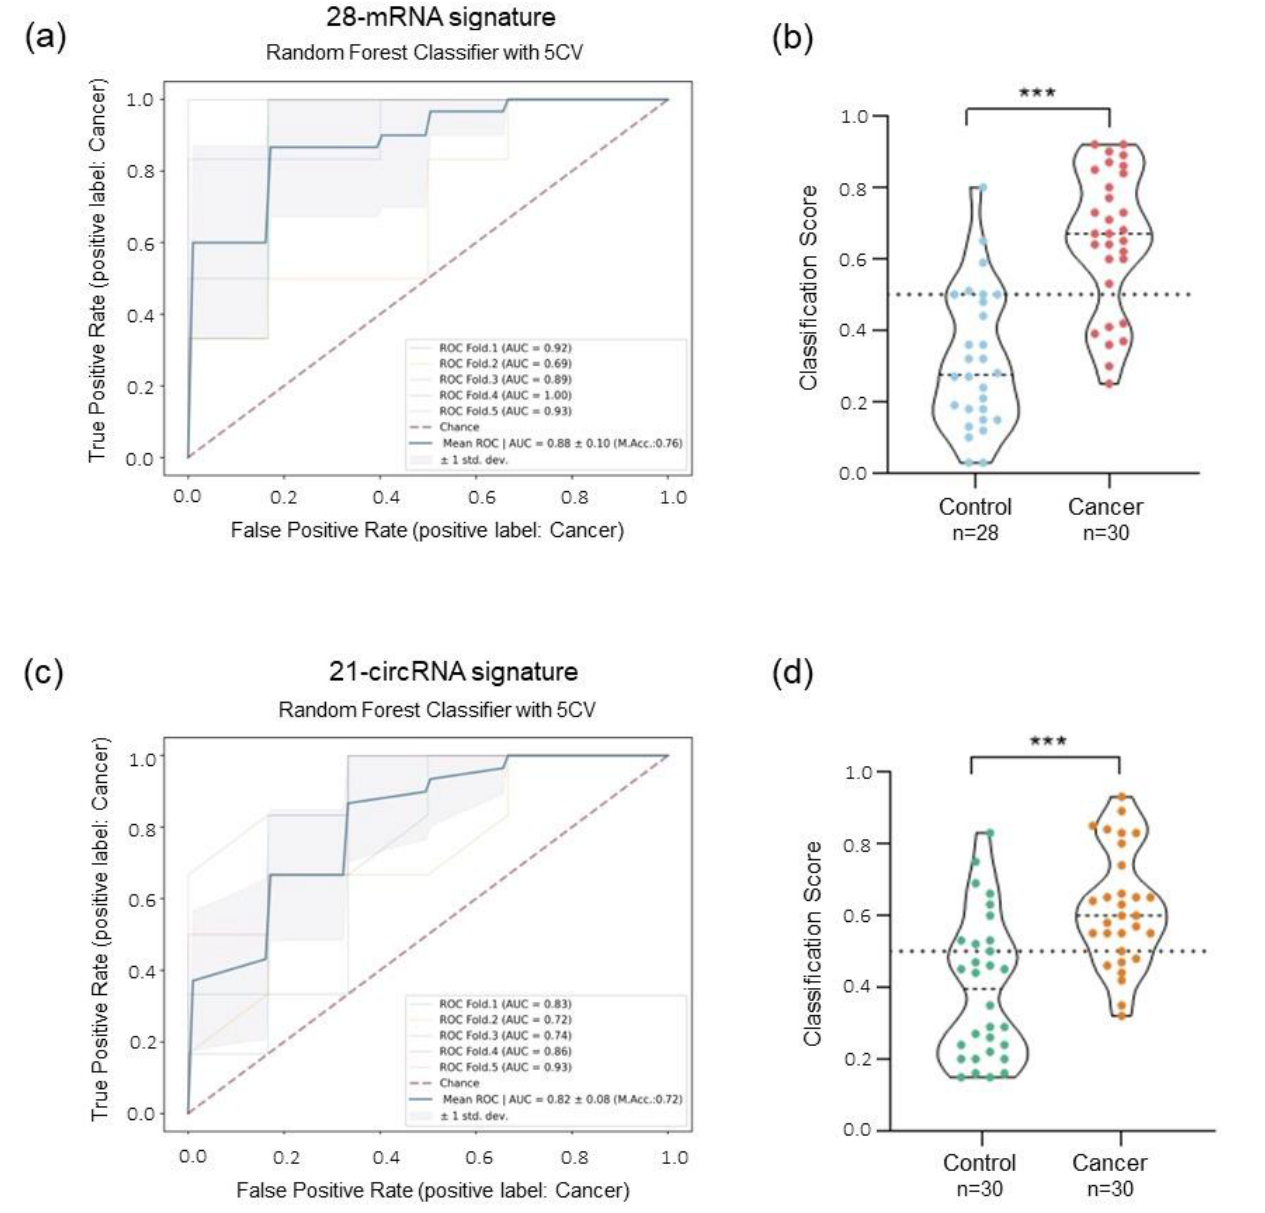
Figure 5. ML analysis using single signature of mRNA and circRNA. ( a ) AUC ROC curve of the 28-mRNA signature using RF classifier for group classification. ( b ) Violin plot of the classification score of samples generated using the 28-mRNA predictive model (*** indicates p -value < 0.001 in a two-tailed Mann–Whitney U test). ( c ) AUC ROC curve of the 21-circRNA signature using RF classifier for group classification. ( d ) Violin plot of the classification score of samples generated using the 21-circRNA predictive model (*** indicates p -value < 0.001 in a two-tailed Mann–Whitney U test). In terms of AUC, accuracy, and specificity, this model outperforms the results seen in the previous models using an independent signature of mRNA or circRNA, suggesting a potential synergistic role of the combinatorial use of these two RNA types as molecular